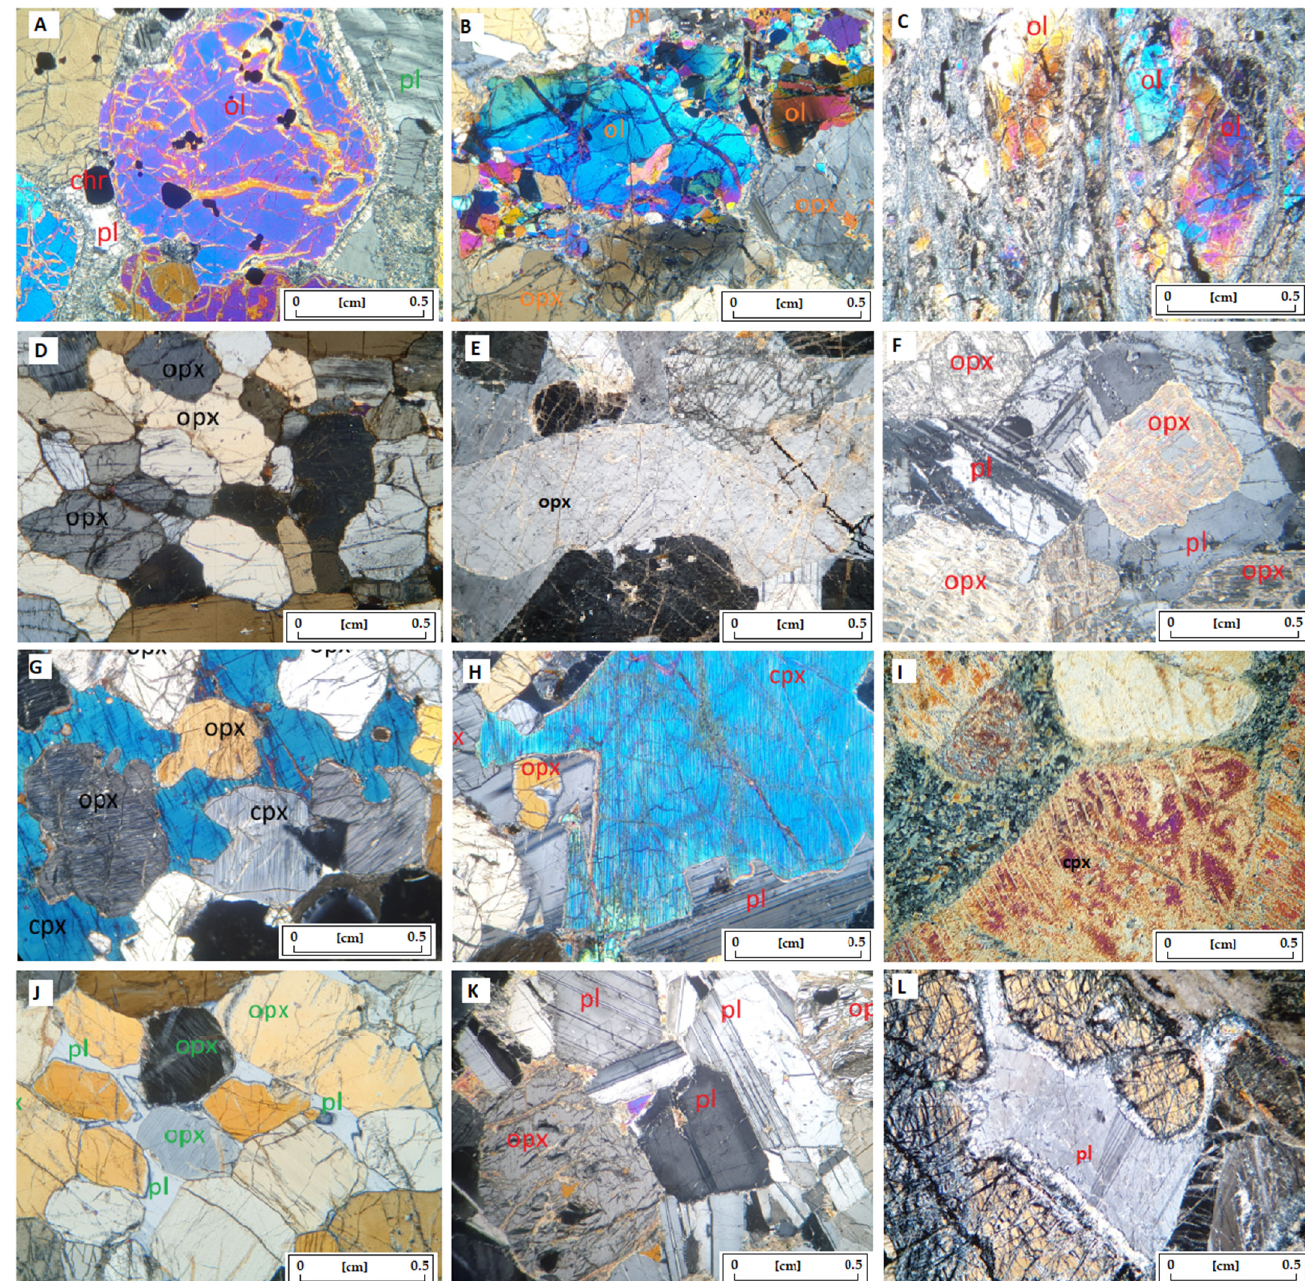
Figure 4. Different shapes of olivine. ( A – C ) Orthopyroxene. ( D – F ) Clinopyroxene. ( G – I ) Plagioclase. ( J – L ) Olivine co-occurring in dunite. ( A ) Euhedral olivine crystal. ( B ) Euhedral olivine crystal in harzburgite. ( C ) Melted olivine in myllonitized peridotite. ( D ) Orthopyroxene in orthopyroxenite. ( E ) Orthopyroxene in harzburgite. ( F ) Corroded orthopyroxene in norite. ( G ) Clinopyroxene in orthopyroxenite. ( H ) Clinopyroxene in norite. ( I ) Clinopyroxene in saussuritized gabbro. ( J ) Plagioclase in orthopyroxenite. ( K ) Plagioclase in norite ( L ) Plagioclase in